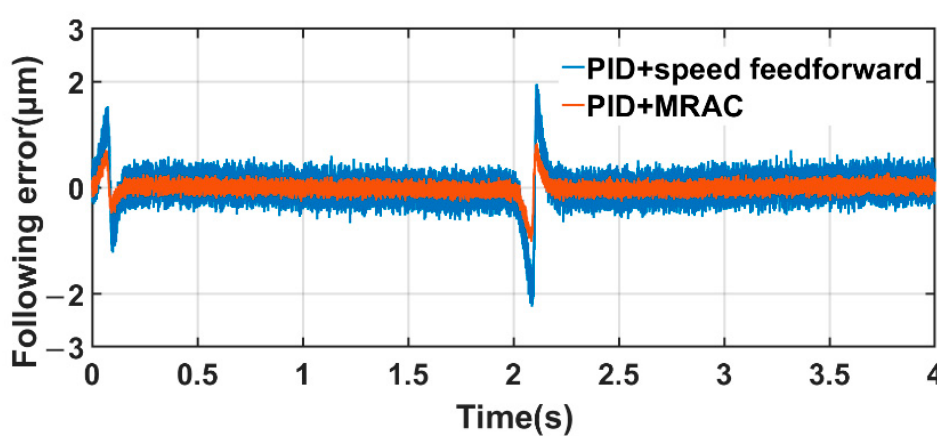
Figure 10. Position noise.